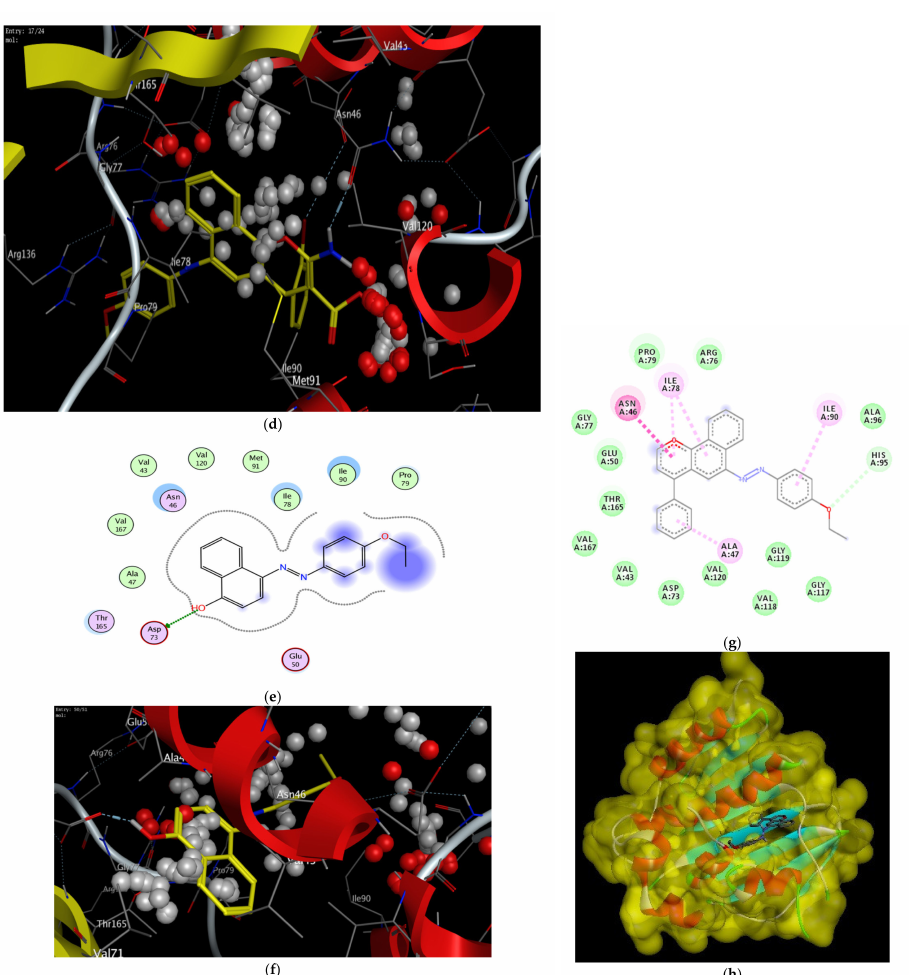
Figure 10. 2D and 3D binding interaction of 1-(4-ethoxyphenyl)-2-(4-phenyl-4 H -benzo[ h ]chromen-6- yl)diazene derivatives inside the enzyme. ( a , b ) Derivative 4b , ( c , d ) derivative 4h , ( e , f ) Fat brown B dye, and ( g , h ) unsubstituted chromene